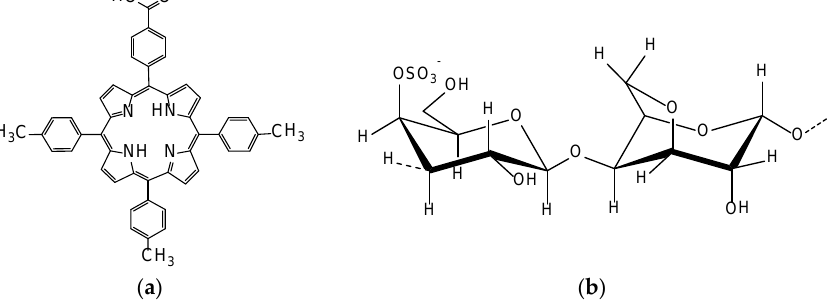
Figure 1. Structures of 5-(4-carboxyphenyl)-10,15,20-tris-(4-methyl-phenyl)-porphyrin (5-COOH- 3MPP) ( a ) and of k-carrageenan ( b ).